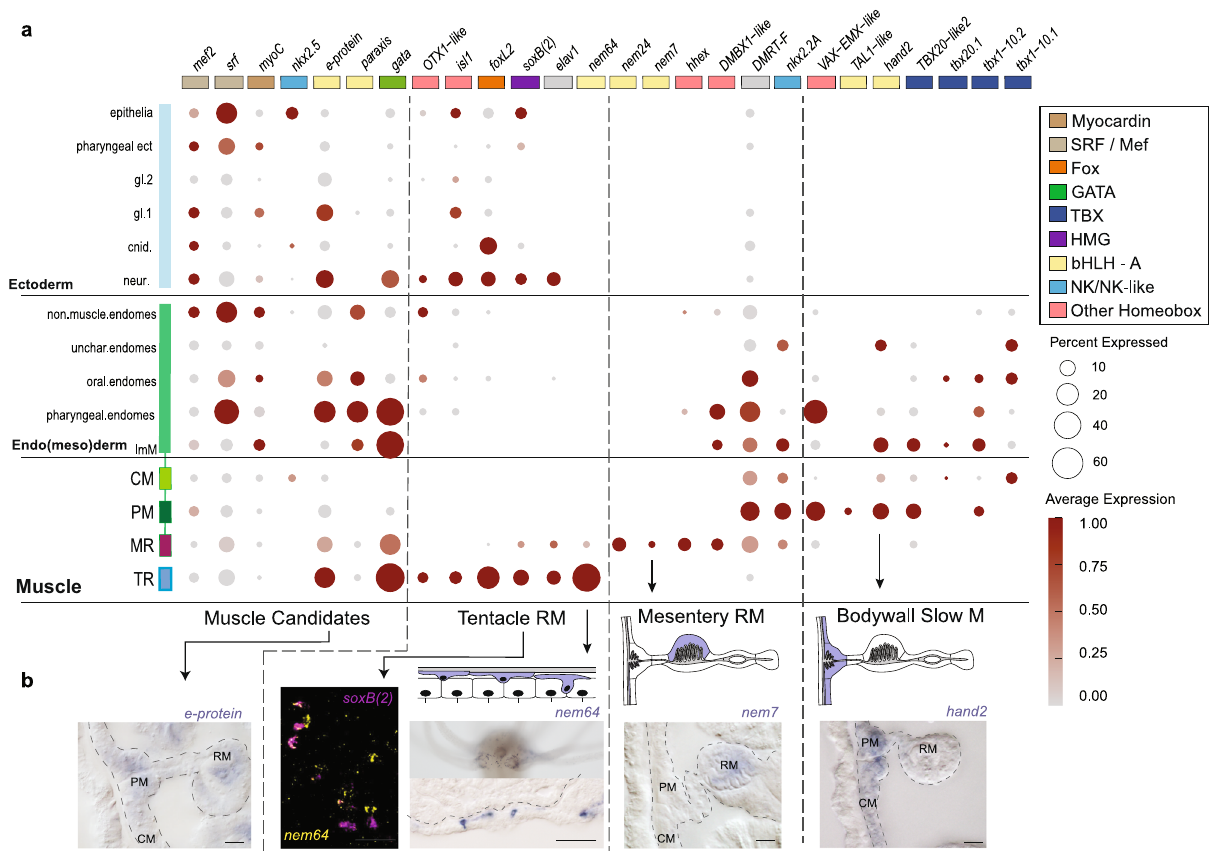
in the legend. Gene sets are organized according to expression pro fi le (Muscle Candidates, TentacleRM, MesenteryRM, BodywallSlow M).The relative positions of the muscle cells are shown schematically below the dot plot. b Validation of selected pro fi les by in situ hybridization. Scale bars are 20 µ